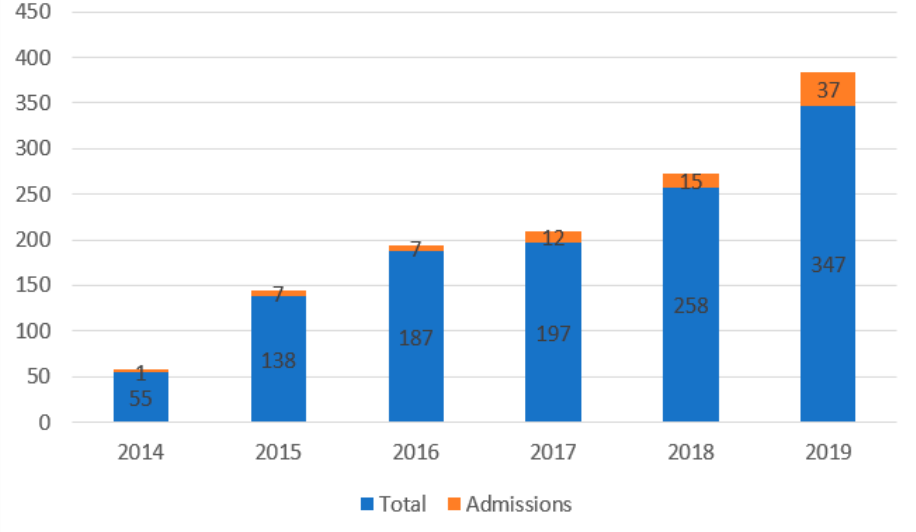
Figure 1. Number of admissions from total cohort by year.